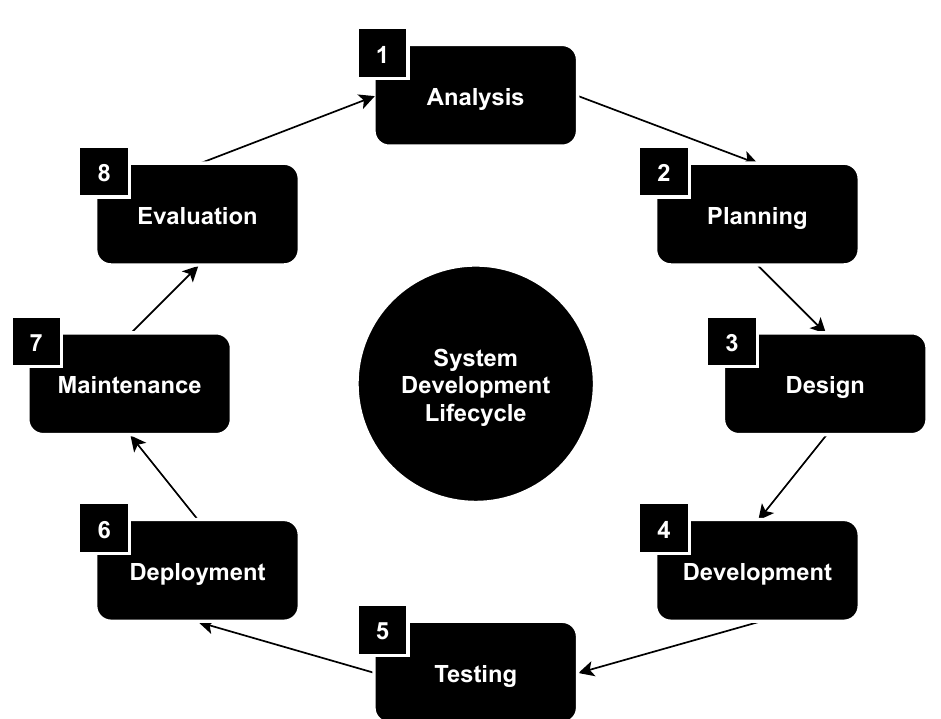
Figure 1. Microcontroller-based systems development